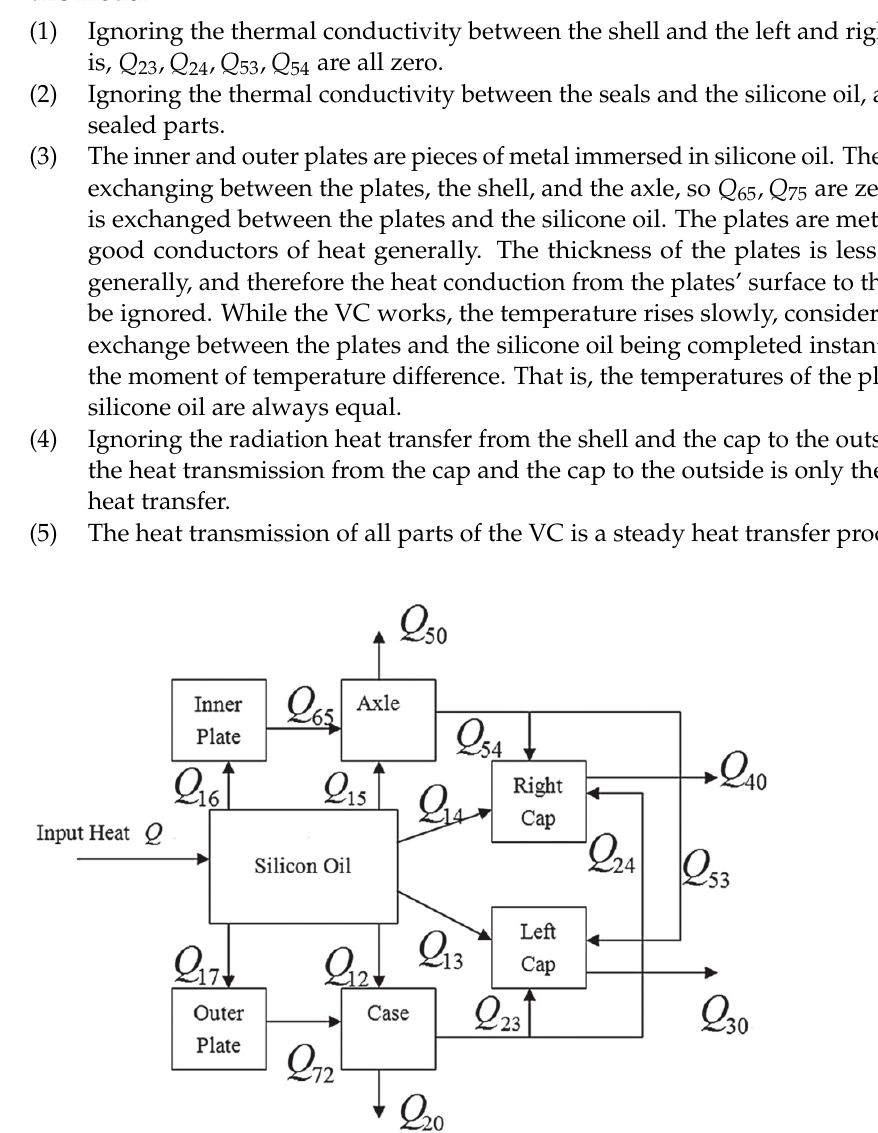
Figure 3. A heat-transfer model for a VC.